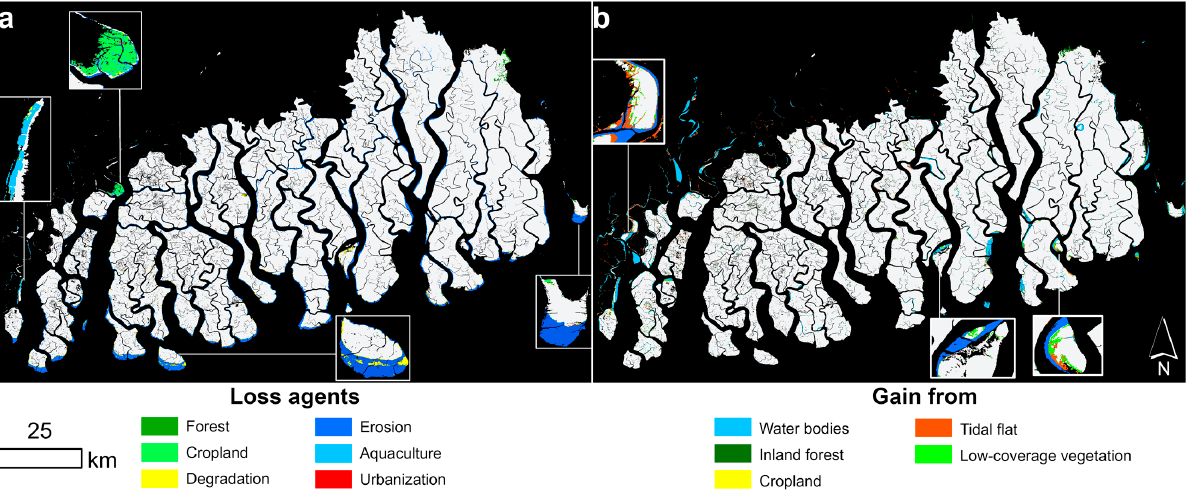
Figure 8. Change agent maps with some regional subsets. ( a ) Mangrove loss agents. ( b ) Land-cover types from which mangroves gained.